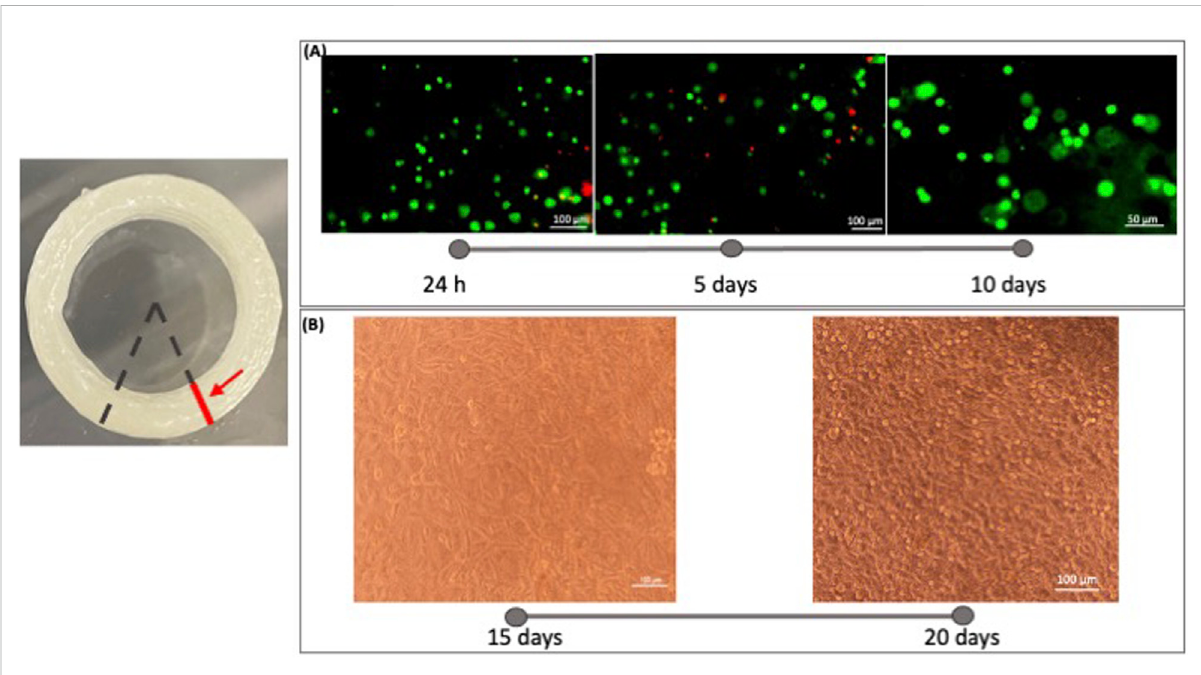
FIGURE 7 Microscope images were acquired on the sample section. The red line indicates the section plane on which the acquisition took place. The analysis of cell viability in the 3D bioprinted constructs was performed using a Live/Dead viability/Cytotoxicity kit (Invitrogen, United States). (A) Fluorescence images were taken at 1 day, 5 days, and 10 days to evaluate the live (green) and dead (red) staining cells in the printed constructs with microscopy Eclipse Ti2-E (Nikon). Three random views from each sample were photographed and analyzed using Fiji ImageJ software. From these images, we can say that the developed bioink is biocompatible and cytocompatible. (B) Images of the cell in fi ltration were captured at 15 and 20 days of culture. Comparing the images of different time points we can appreciate a cell growth into the 3D Bioprinted